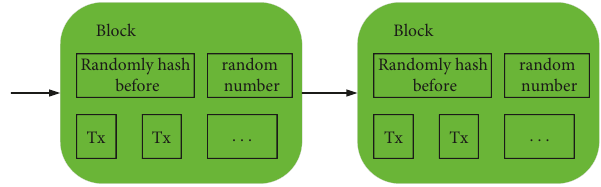
Figure 3: Partial structure of